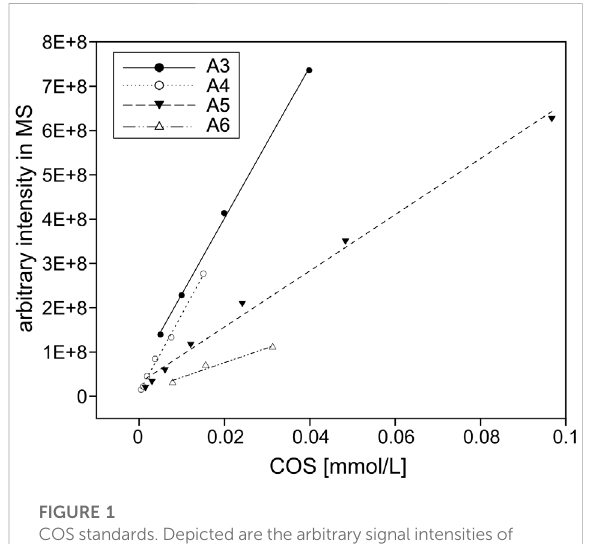
FIGURE 1 COS standards. Depicted are the arbitrary signal intensities of the ions measured by the LC-MS for up to 0.1 mM fully acetylated trimer to hexamer (A3 – A6). All linear regressions feature R 2 values above 0.96 and were used to quantify COS in this study.